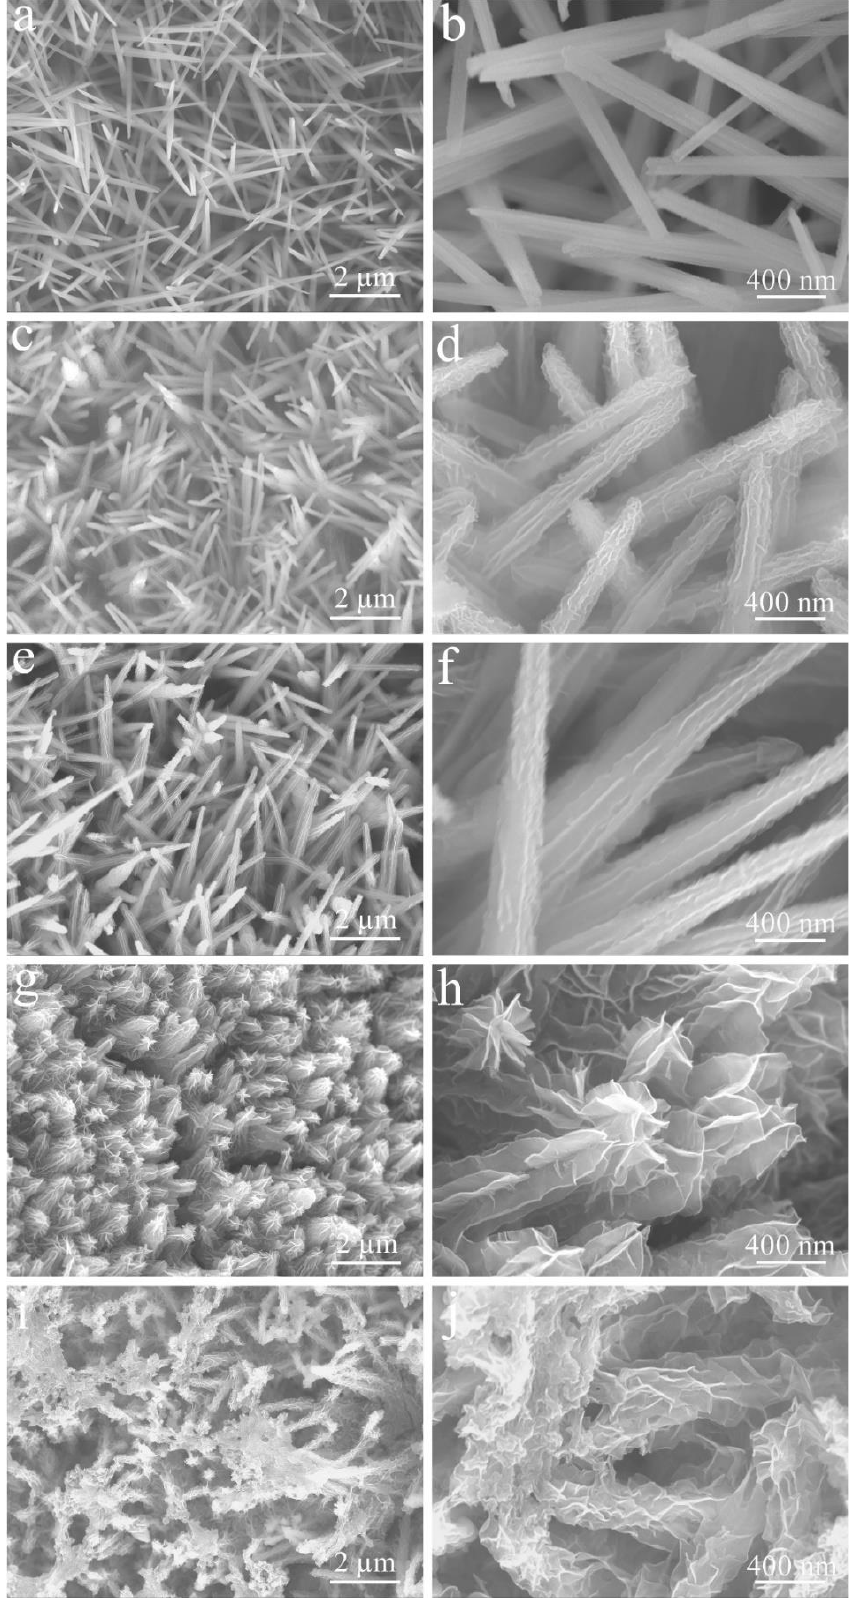
Figure 5. FE-SEM images of NCS electrodeposited on Cu(OH) 2 nanorods for different CH 4 N 2 S concentrations: ( a , b ) 0.05 M, S-1; ( c , d ) 0.25 M, S-2; ( e , f ) 0.5 M, S-3; ( g , h ) 0.75 M, S-4; ( i , j ) 1 M,